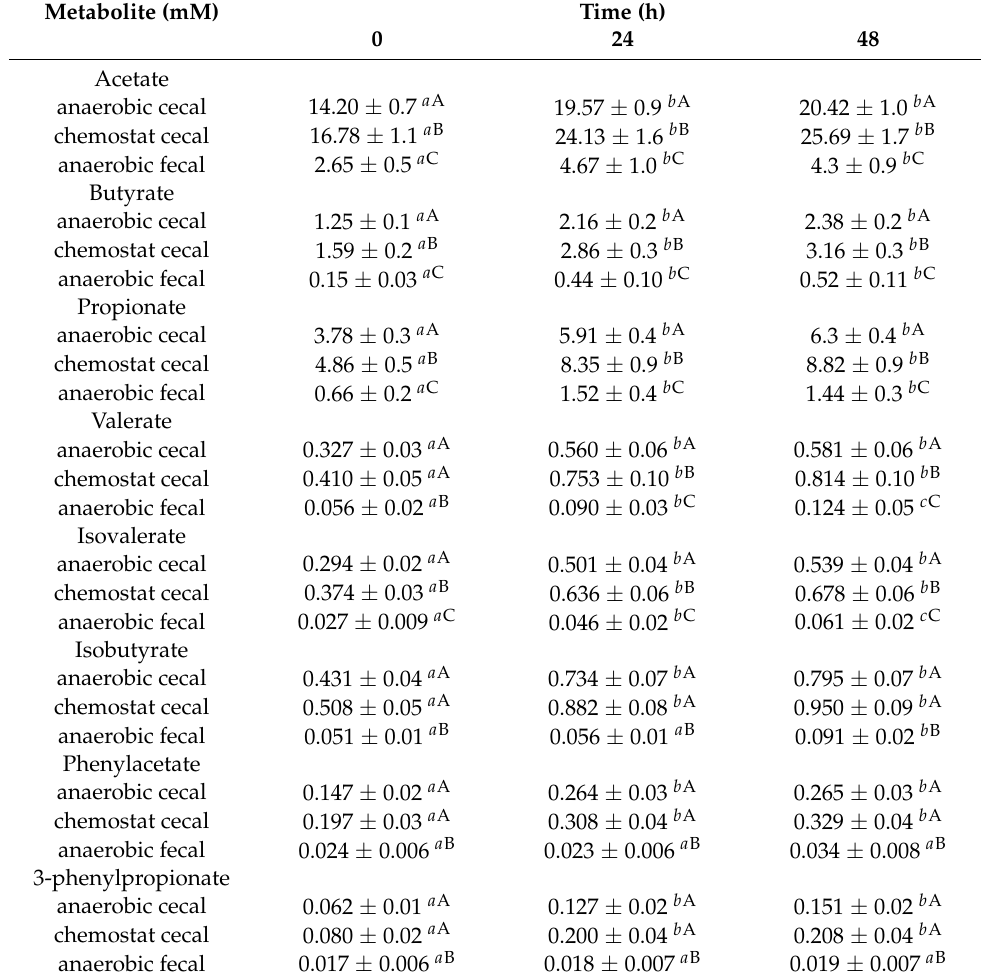
Table 2. Metabolite concentration (mM) as measured by NMR over time in inoculum maintained under different fermentation